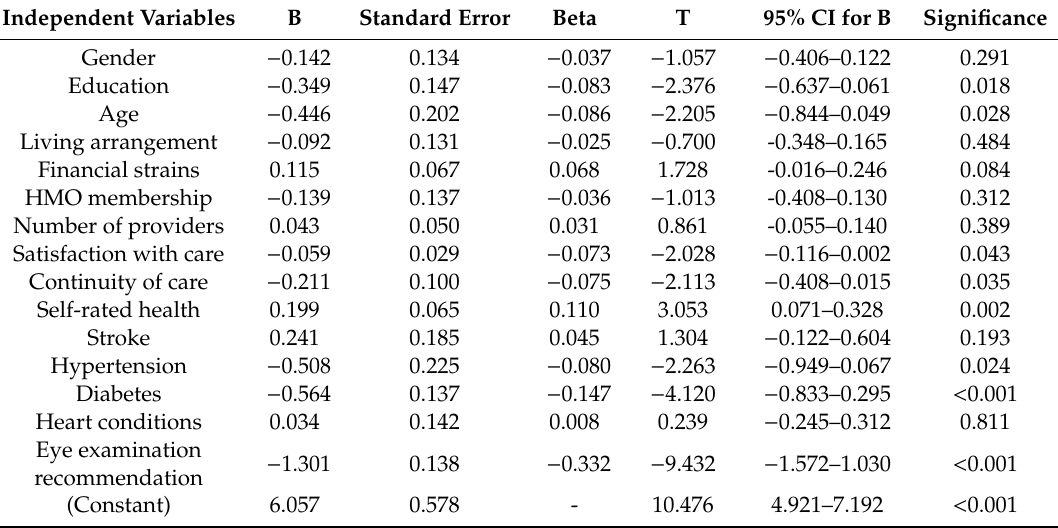
Table 4. Multiple linear regression between explanatory variables and recency of eye examination among underserved middle-aged and older African-American adults ( n =